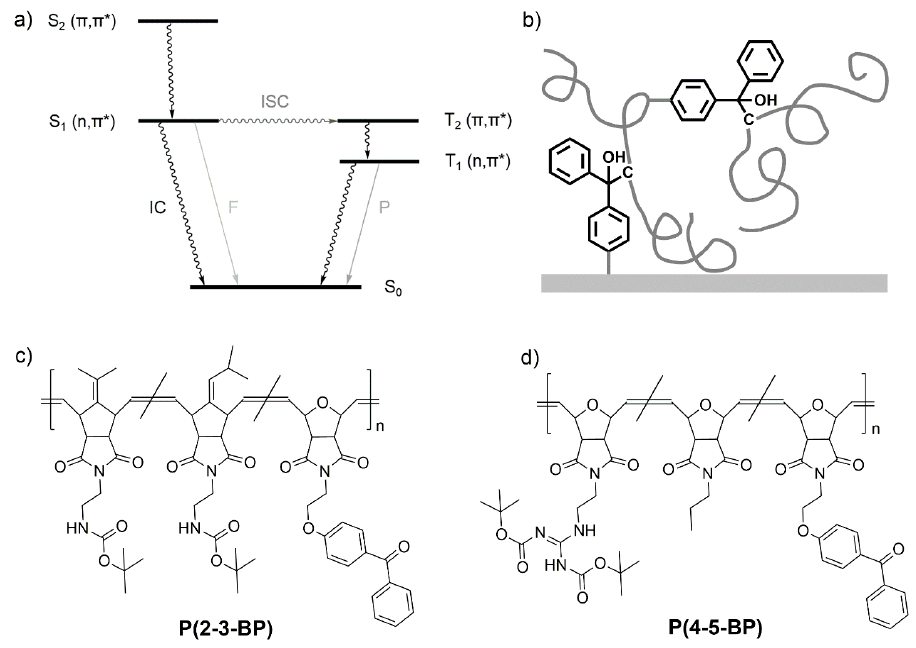
Figure 1. ( a ) Simplified Jablonski diagram of benzophenone illustrating its electronic states and possible transitions by internal conversion (IC), intersystem crossing (ISC), fluorescence (F) and phosphorescence (P) [16]; ( b ) Cartoon illustration of a surface-attached polymer network with benzophenone as surface anchor group and chain-chain cross-linker; ( c , d ) Structure of the poly(alkenylnorbornenes) P(2-3-BP) and poly(oxonorbornenes) P(4-5-BP) used in this study.